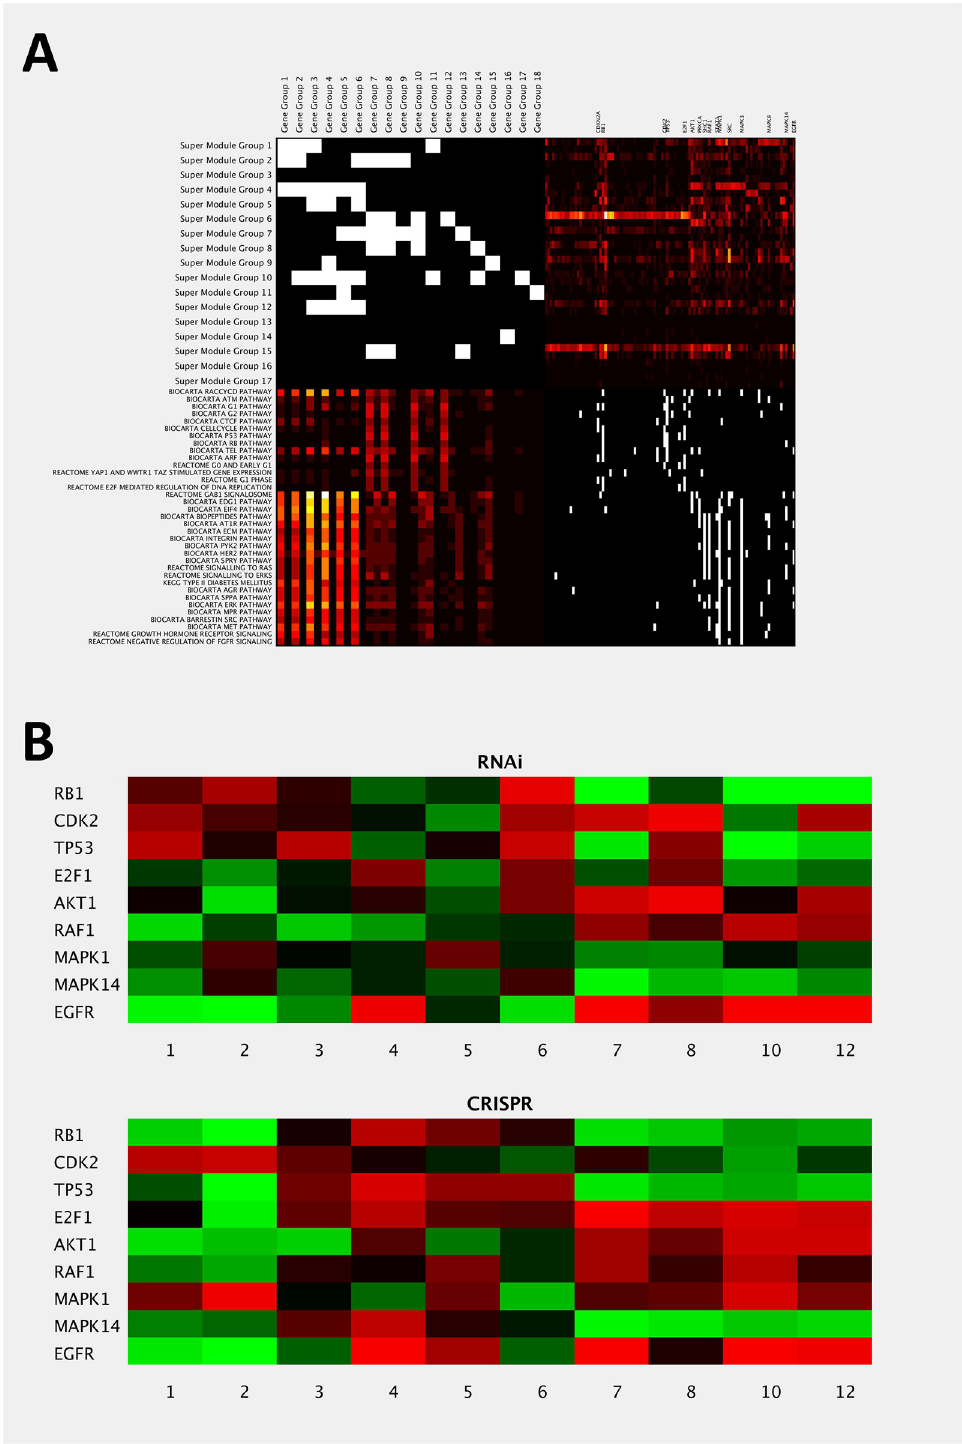
Fig 6. IHAS integrated views in multiple cancer types. A : An integrated view of recurrent hub effectors and the functions of their impacted target genes. It consists of four patches. The upper-left patch ( M 1 ) shows the binary over- representation matrix of Gene Groups in Super Module Groups (S1E Table). The upper-right patch ( M 2 ) shows the occurrence frequencies of 101 selected hub effectors in each Super Module Group. The counts of positive and negative associations are shown in the upper and lower portions of each grid. The lower-right patch ( M 3 ) displays the membership